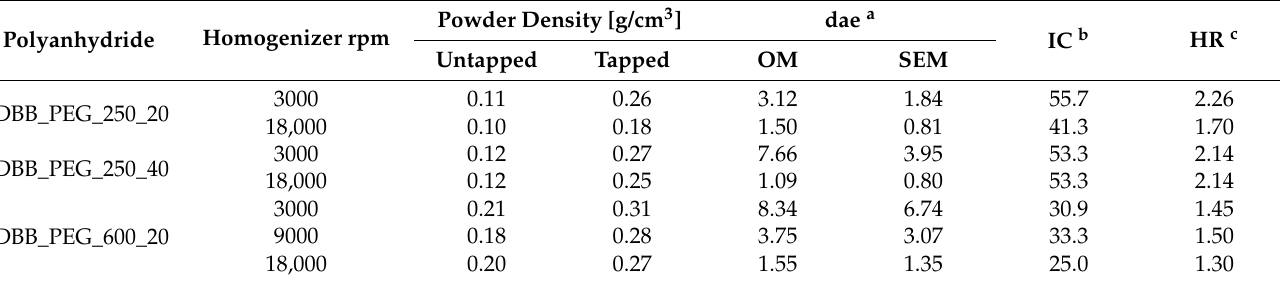
Table 5. Aerodynamic characteristic of microspheres obtained from polyDBB_PEG.